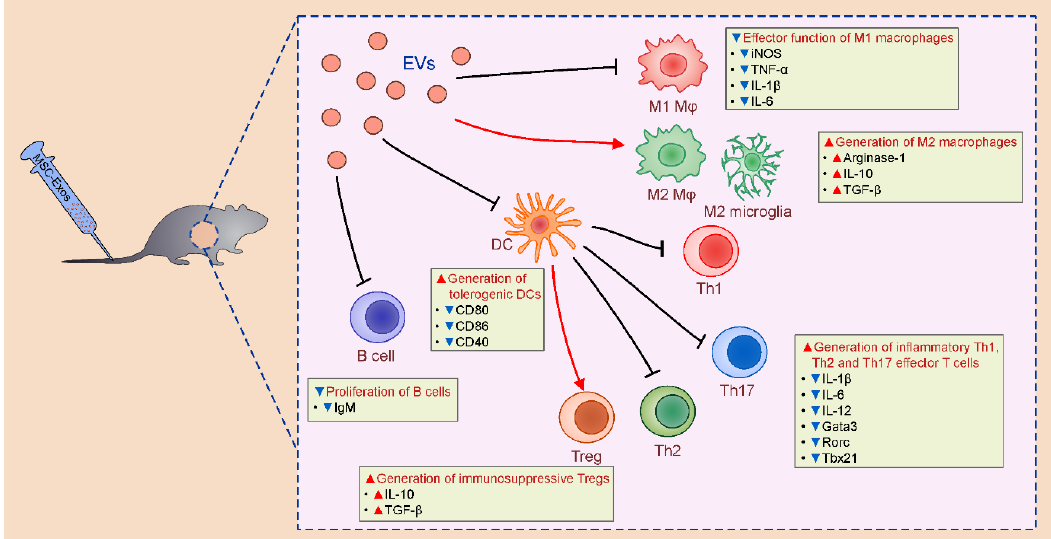
Figure 2. Immunomodulatory effects of MSC-Exos. MSC-Exos modulated effector function of dendritic cells (DCs), macrophages, T and B lymphocytes. MSC-Exos attenuated antigen-presenting properties of DCs, inhibited proliferation of B lymphocytes, suppressed generation of inflammatory M1 macrophages, Th1, Th2, and Th17 cells and induced enhanced expansion of